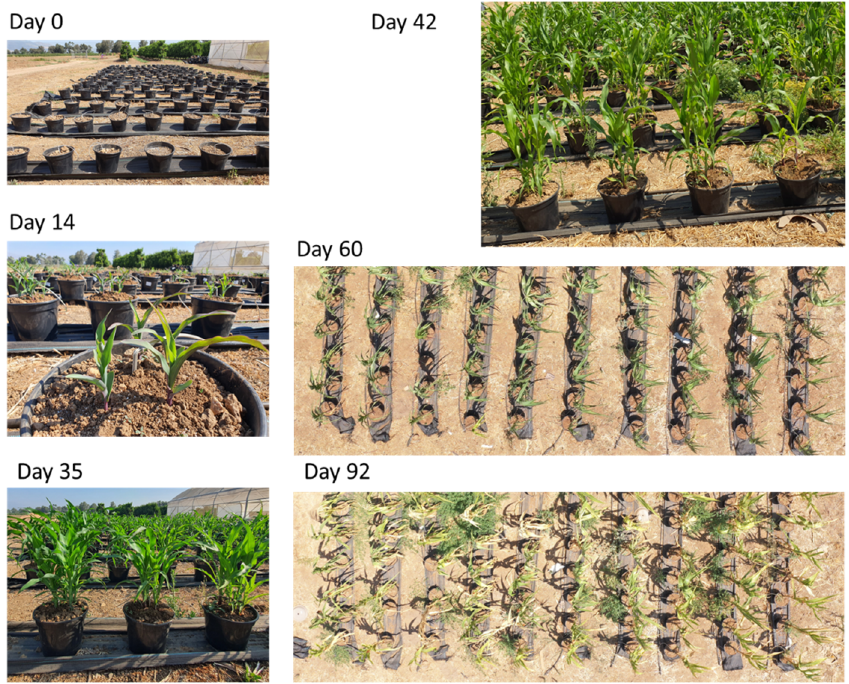
Figure 7. The open-air pots experiment’s pictures. Photos were taken from the ground and air throughout the growing season.